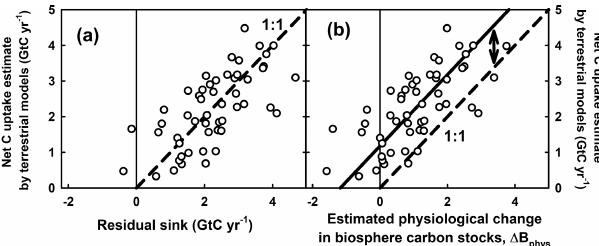
Figure 8. Mean estimates of net carbon uptake by the biosphere plotted against the residual sink (a) , or as a function of the revised (cid:49)B phys calculated here (b) . Data have been taken from Le Quéré et al. (2018), with each point corresponding to an annual flux es- timate since 1959. Data were calculated as given in Eq. (1). The dashed lines are 1 : 1 lines, and the solid line in (b) is off-set by 1.2GtCyr − 1 but retains a slope of